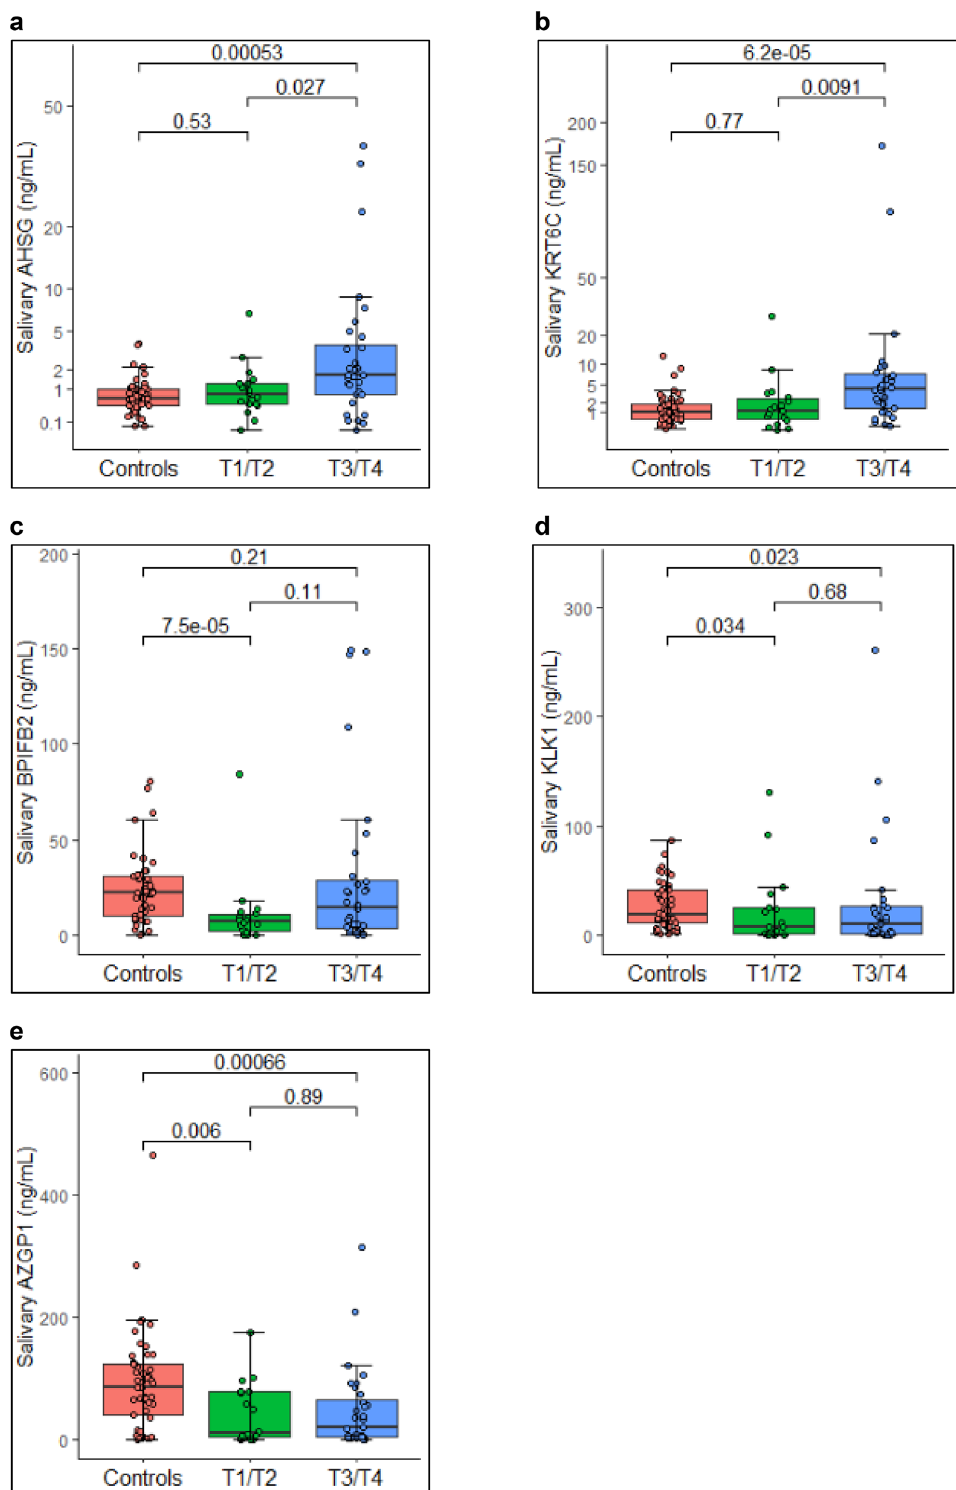
Figure 2. Levels of significantly dysregulated proteins as per primary tumour stage. Boxplot representing the levels of significantly dysregulated proteins amongst healthy controls (n = 49), T1/T2 stage OSCC (n = 18) and T3/T4 (n = 36) stage OSCC cases (Each dot represents individual value). Proteins ( a ) AHSG and ( b ) KRT6C were significantly upregulated in late stage cases. Proteins ( c ) BPIFB2 and ( d ) KLK1 were downregulated in both the stages while ( e ) AZGP1 was significantly downregulated in early stage cases. Wilcoxon sum rank test was used to compare the median protein levels of controls and cases (p < 0.5 was the cut off for statistical